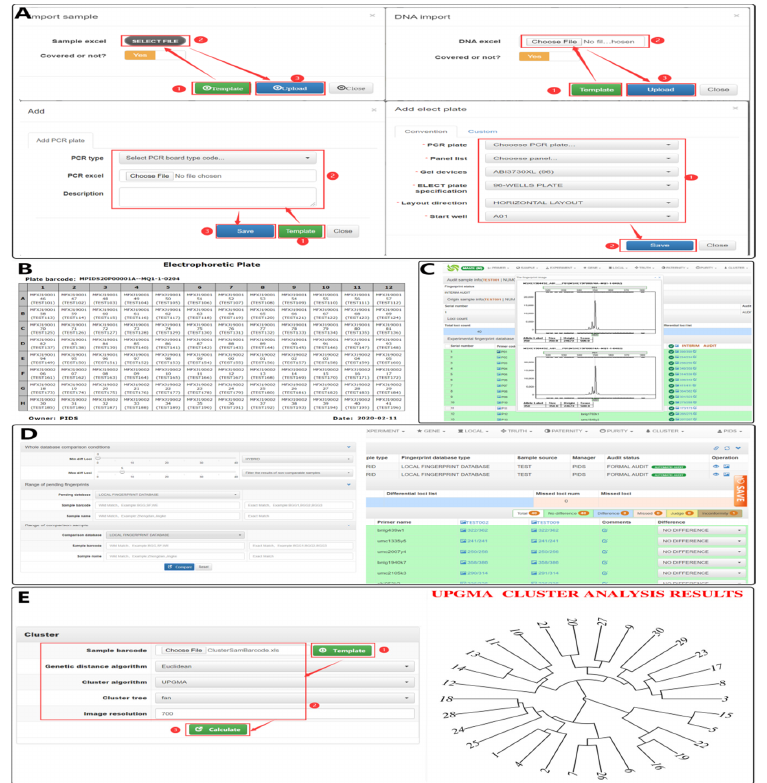
Figure 4. The PIDS interface and representative workflows. ( A ) Users can import the sample information table and DNA information table of the experiment, and automatically create PCR and electrophoresis plates according to the given condition parameters. ( B ) Users can print the automatically generated electrophoresis plate hole position information table for actual DNA detection experiments. ( C ) Users can view the fingerprint data and map information submitted for